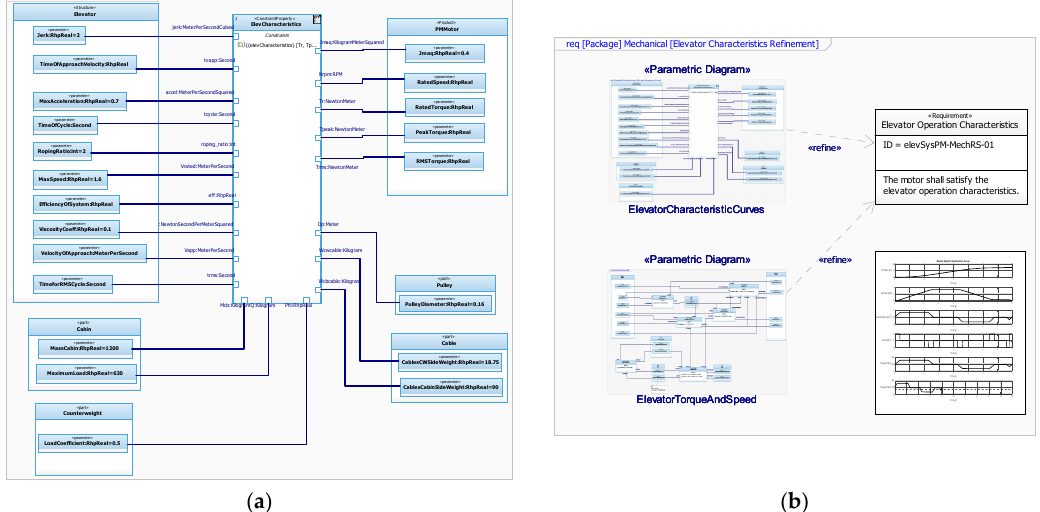
Figure 13. Elevator operator characteristics refinement: ( a ) Parametric diagram to compute operating characteristics curves; and, ( b ) Requirement refinement through parametric diagrams.